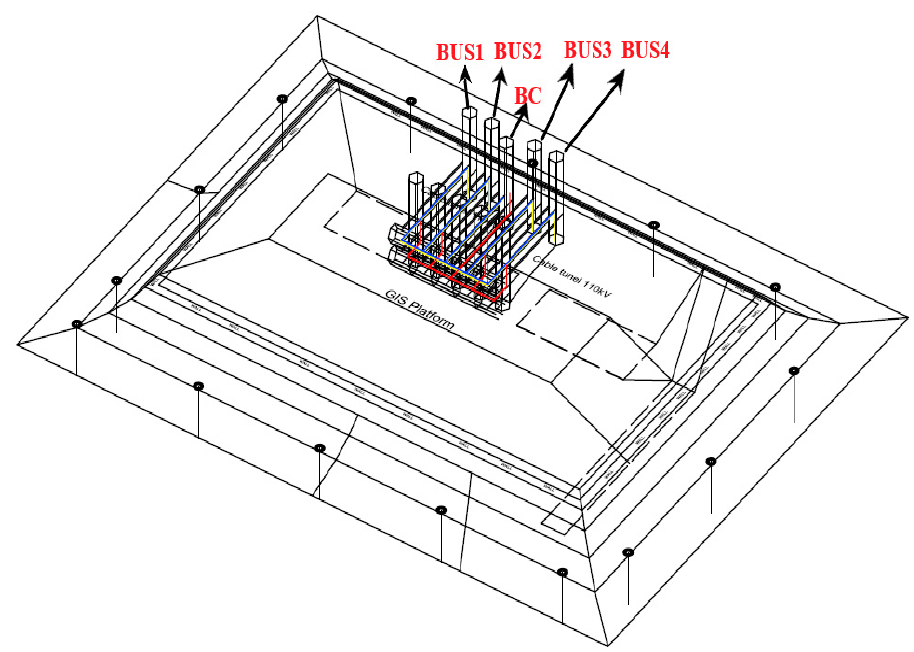
Figure 1. General layout of the substation, initial configuration.